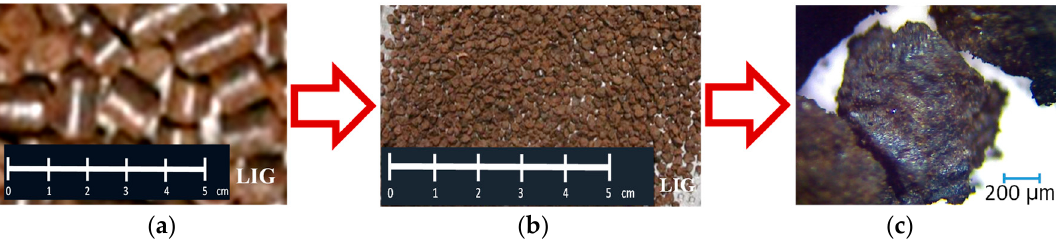
Figure 4. Illustration of selected biomass, lignin, for the agglomeration process: ( a ) lignin pellets, ( b ) after disintegration, ( c ) macro-photo of lignin.